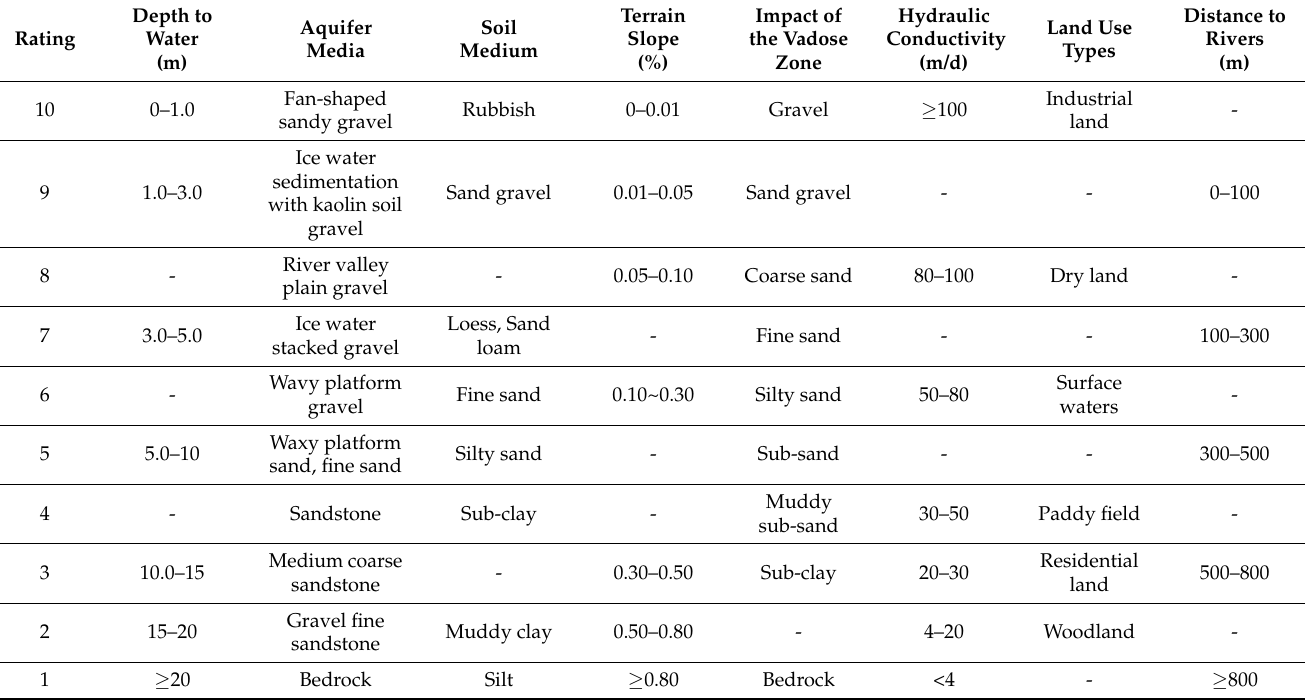
Table 1. Groundwater vulnerability assessment index